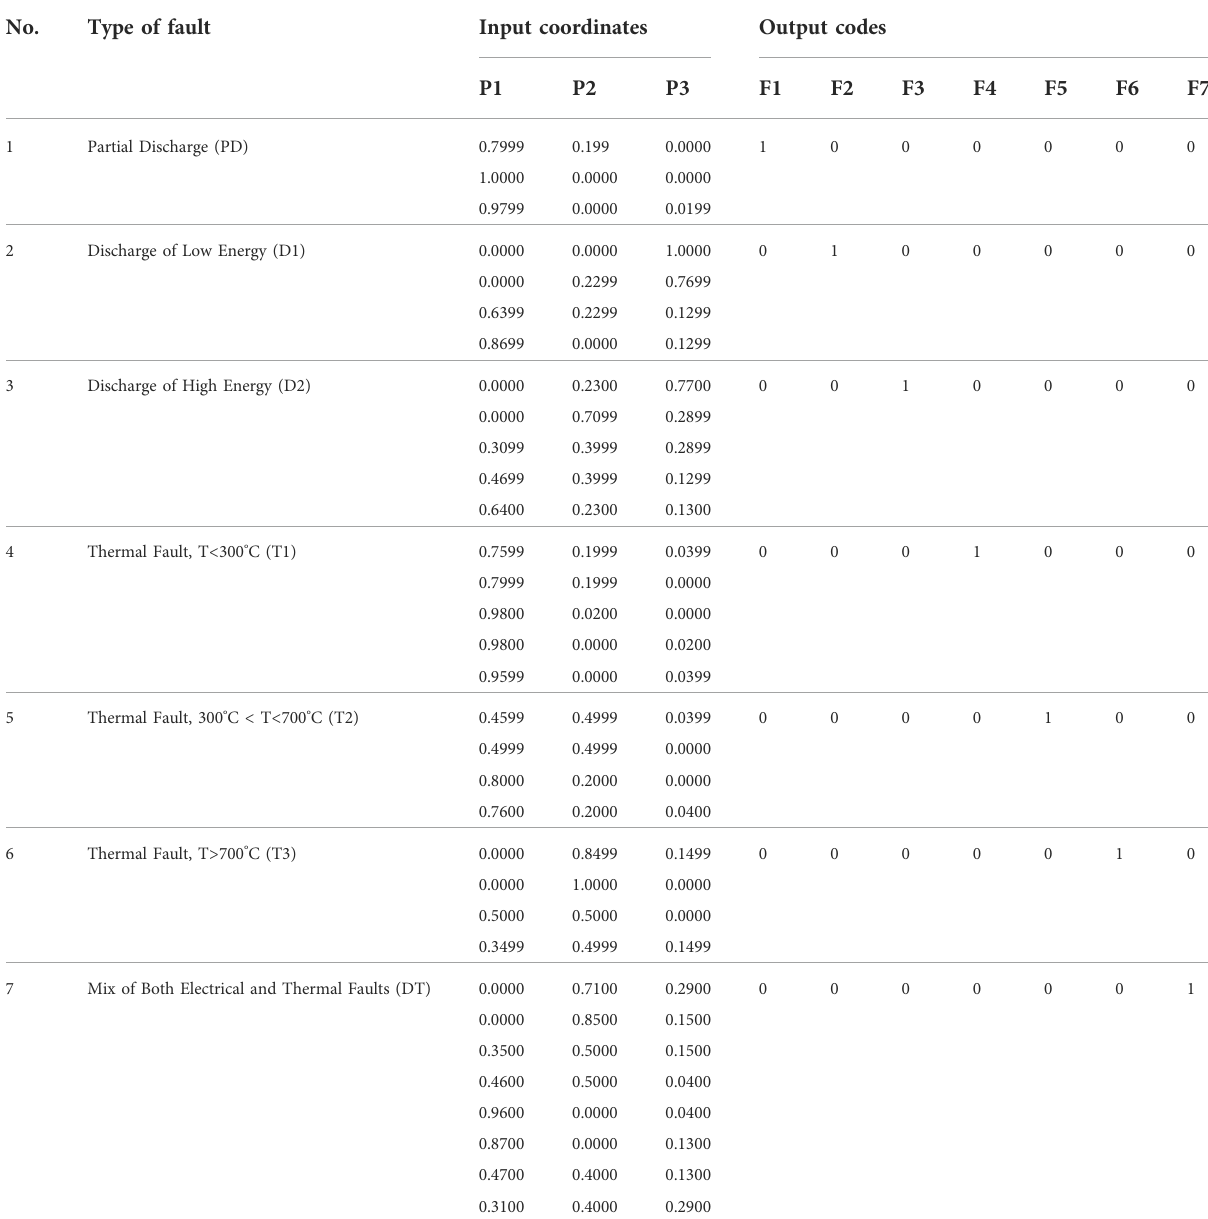
TABLE 1 Input-output codes for the ANFIS model of the Duval ’ s triangle.